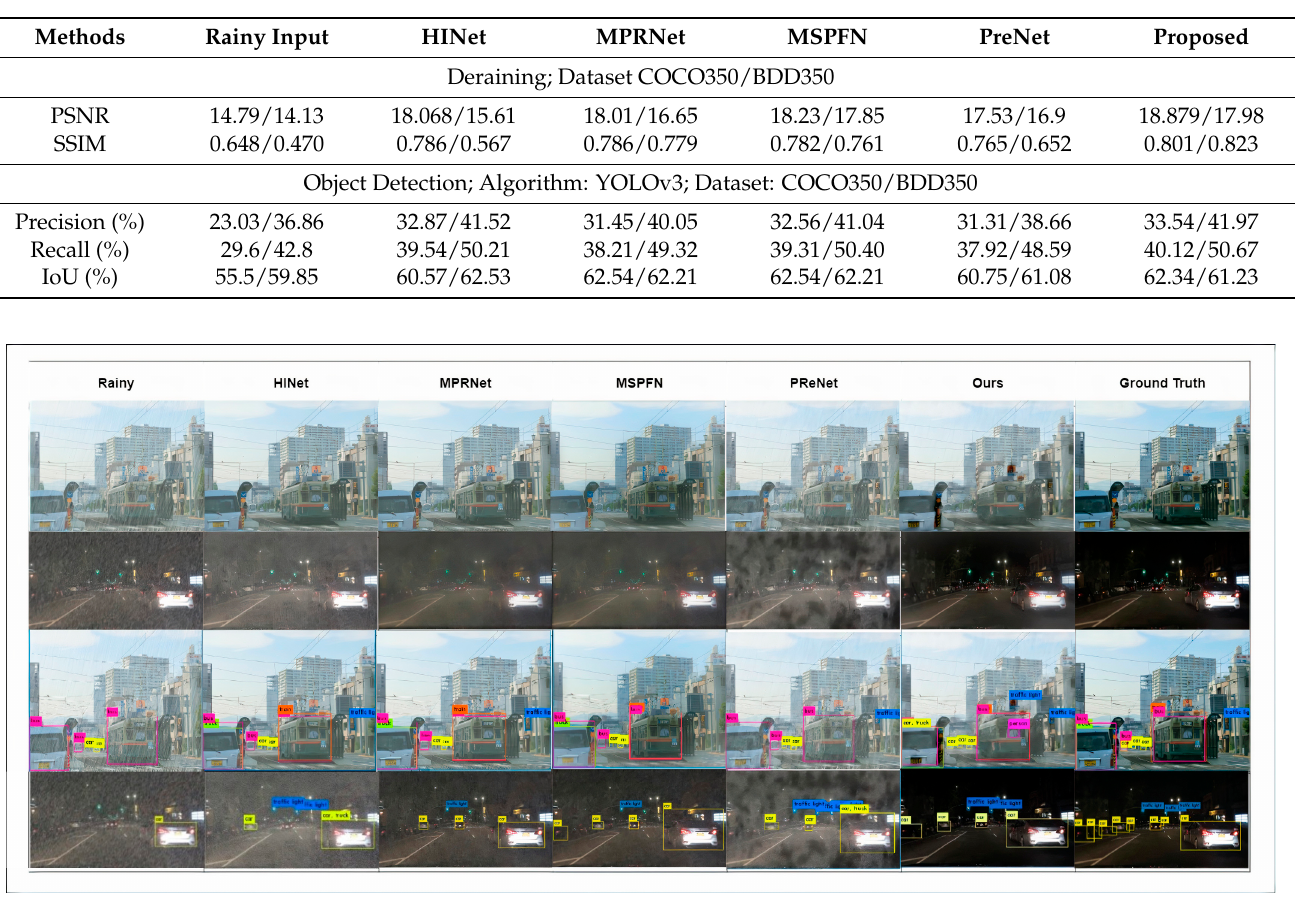
Table 6. Comparison results of joint image deraining and object detection on samples of COCO and BDD datasets.